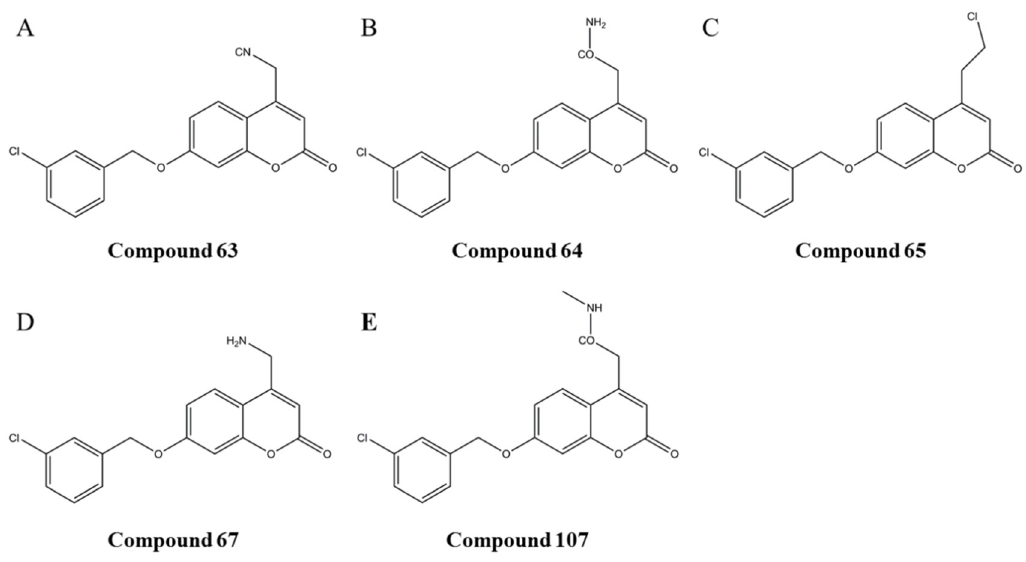
Figure 4. The structures of potential compounds